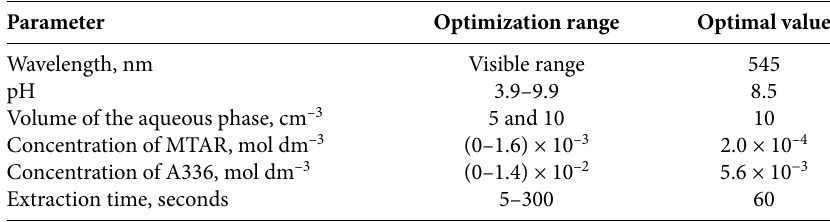
Table 1. LLE-spectrophotometric optimization of the Ni II – MTAR – A336 – water – isobutanol system. The volume of the organic phase was 5 cm 3 .